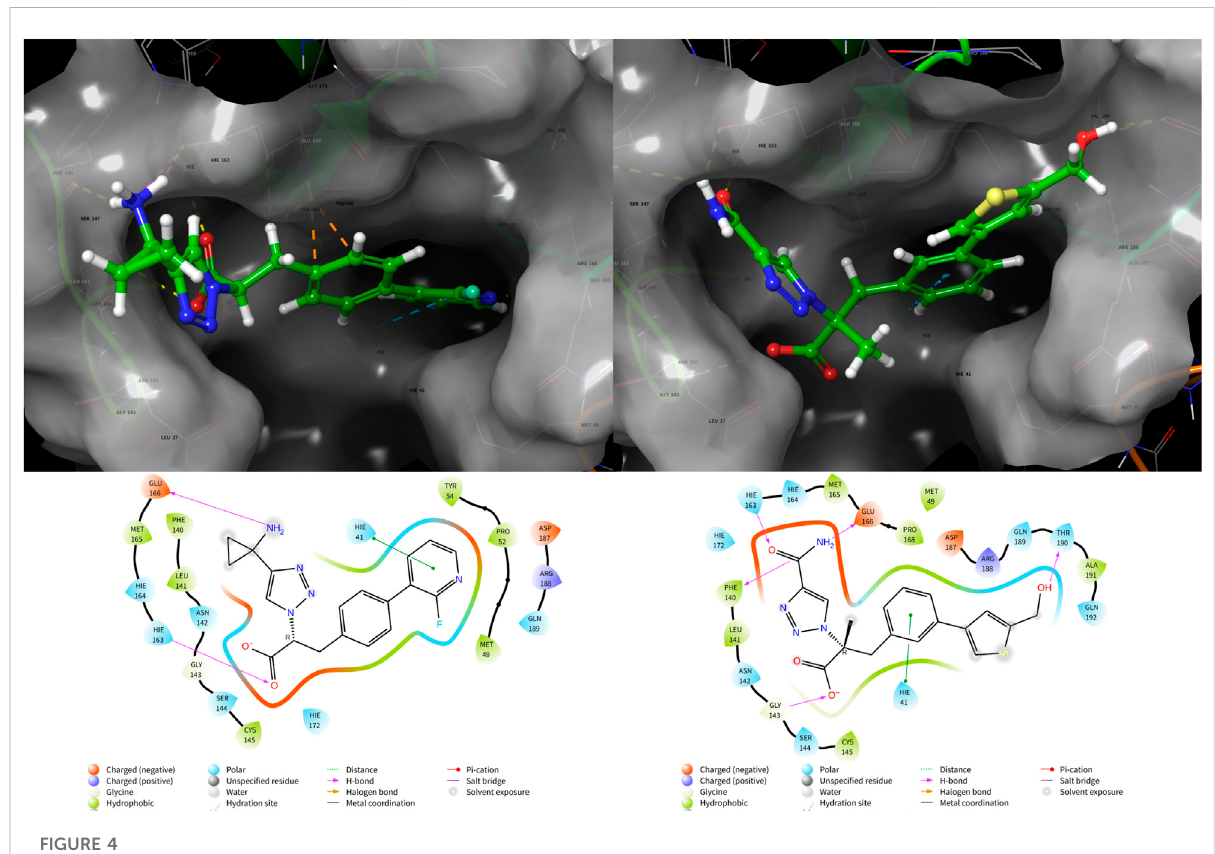
FIGURE 4 Conformation and interaction of N1 (left) and N2 (right) binding to 3CLPro.